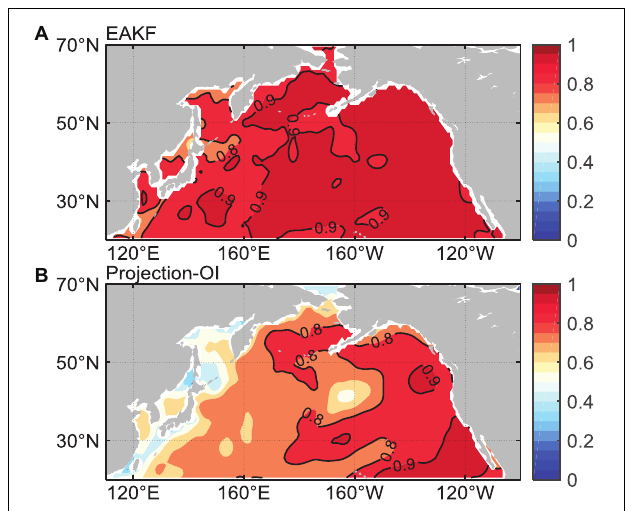
FIGURE 2 | The anomaly correlation coefficient (ACC) of sea surface temperature (SST) between OISST v2 and assimilation results for 1993–2017. (A) EAKF; (B) Projection-OI. ACC is significantly greater than zero at the 95% confidence level. Only the 0.8 and 0.9 contours are plotted.